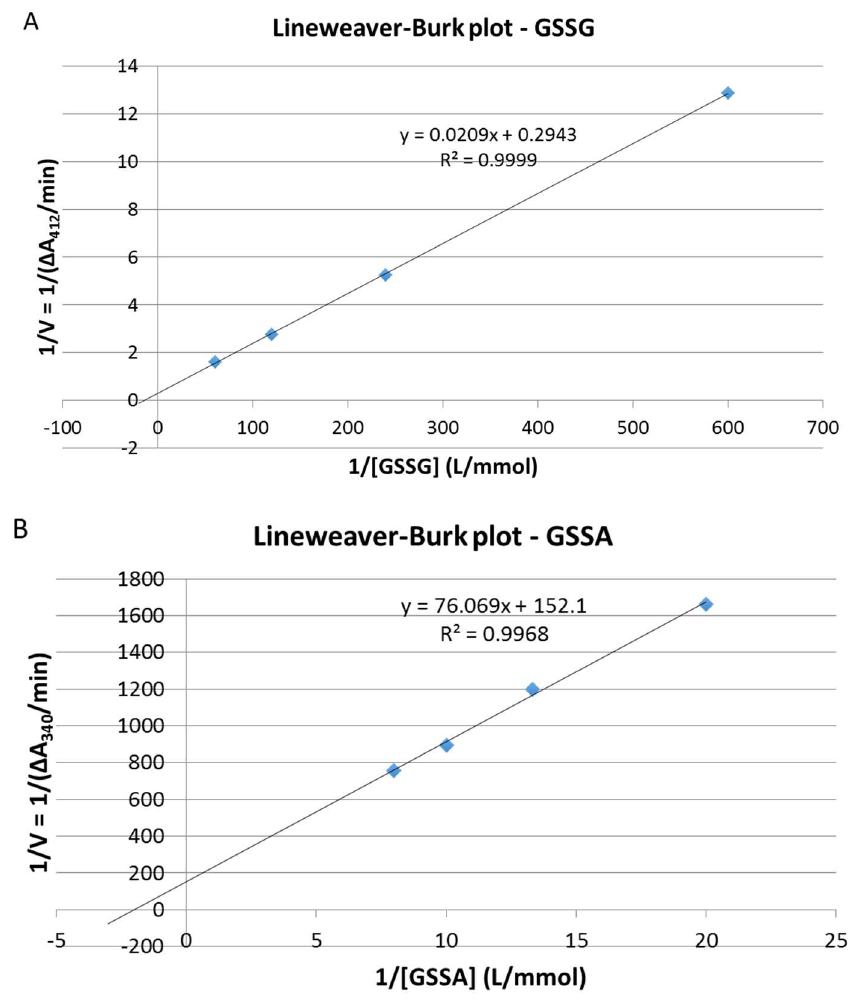
Figure 2. ( A ) Lineweaver-Burk plot for glutathione reductase (GR) with glutathione disulfide (GSSG) + 5,5’-dithiobis-2-nitrobenzoate (DTNB). ( B ) Lineweaver-Burk plot for GR with GSSA without DTNB. The point at which the line intersects the x axis = − 1/ K m . The data from which the individual points were calculated are shown in Supplementary Figure S1A,B and Supplementary Tables S1 and S2.